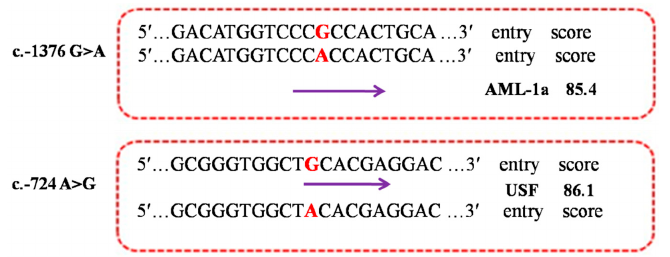
Figure 4. Prediction the alteration of TFBSs in the mutations c.-1376 G>A and c.-724 A>G by using TFSEARCH. The letters in red indicate the position of mutations; the arrows mean the direction of TFBSs.